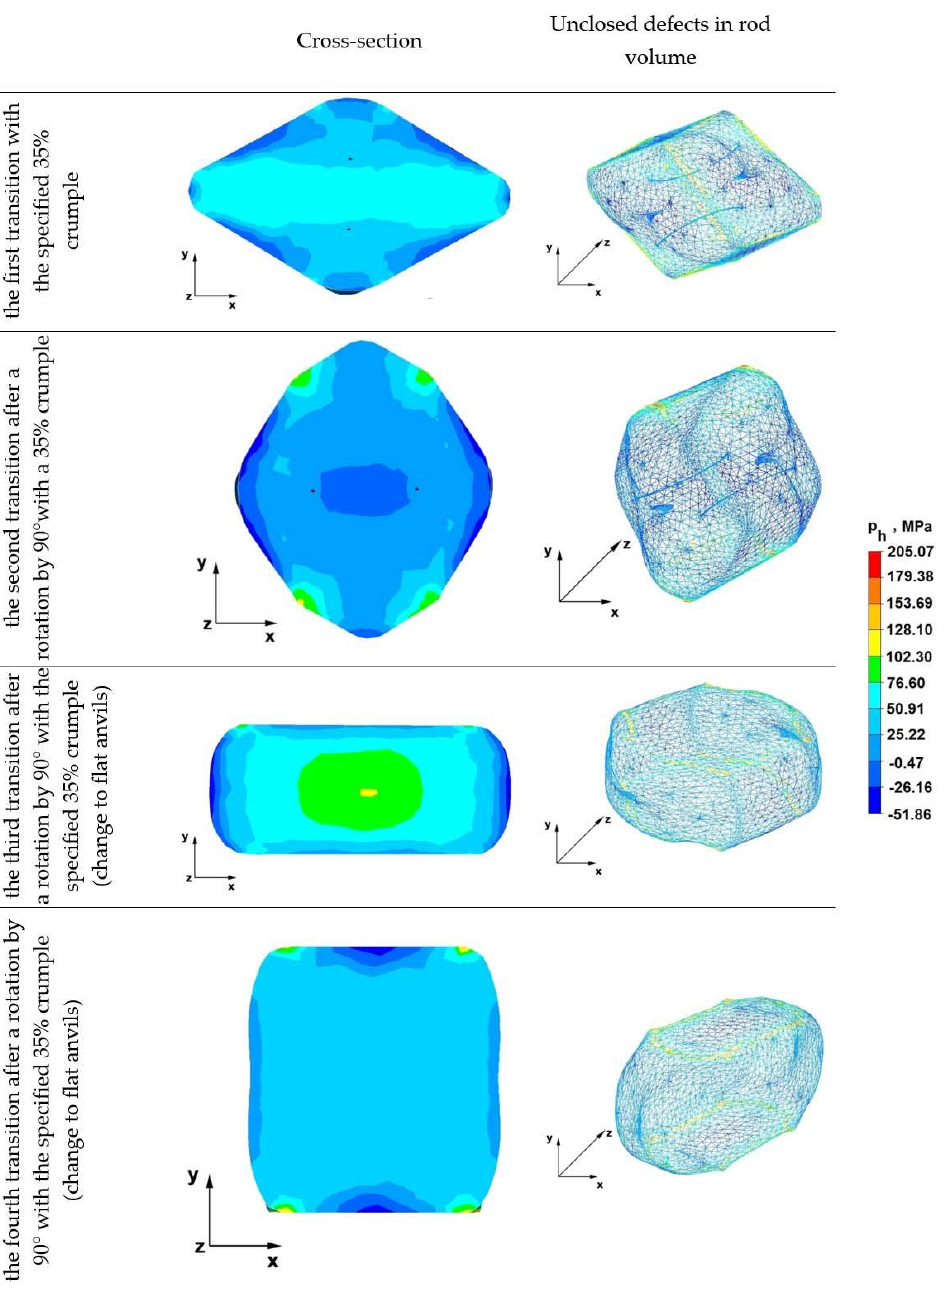
Figure 11. Hydrostatic pressure distribution in rhombic anvils.